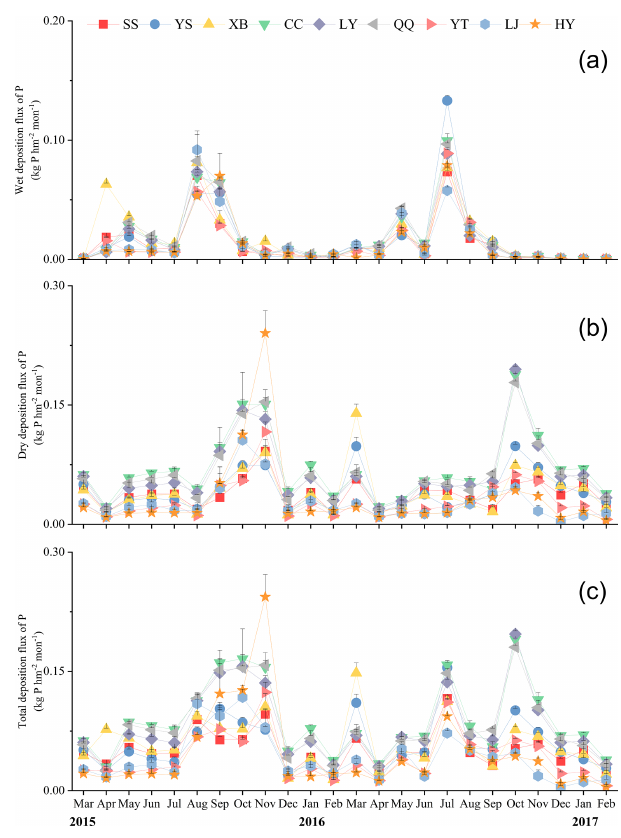
Figure 2. Monthly deposition fluxes of wet (a) , dry (b) and total (c) deposition of P at nine study sites. Error bars represent the stan- dard deviations of three